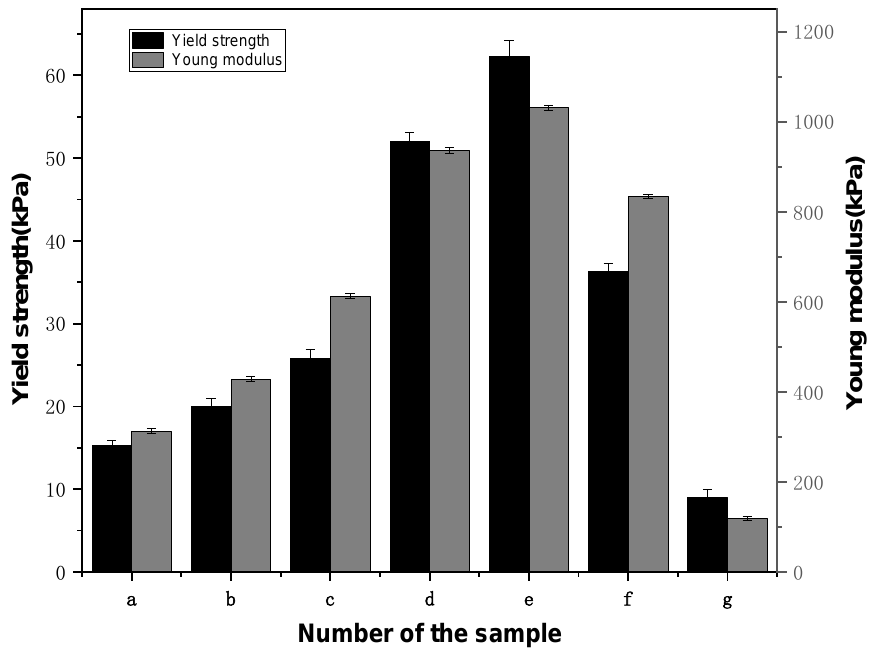
Figure 9. Yield strength and Young’s modulus for materials with different sodium tetraborate con- tents.